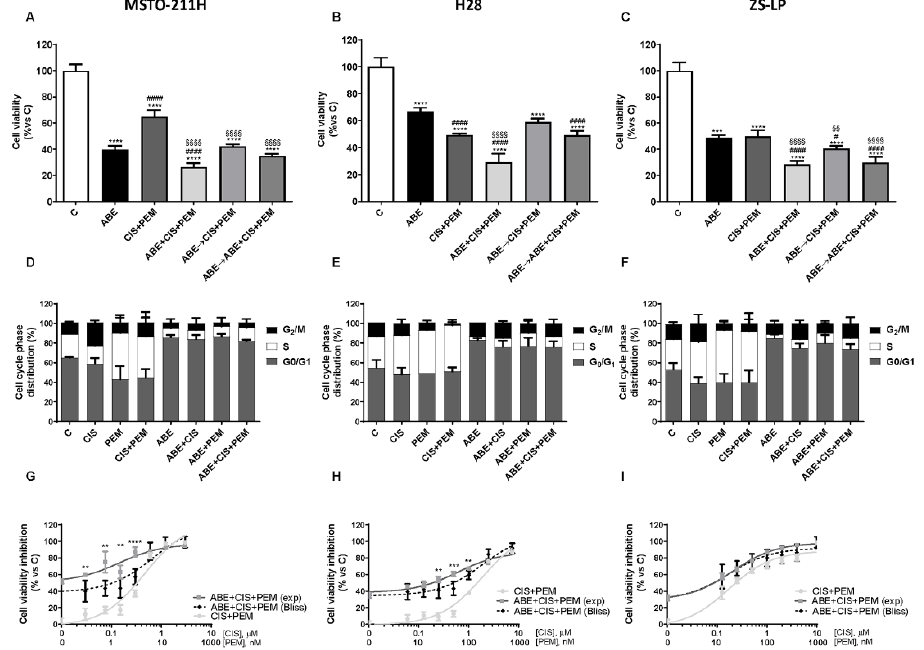
Figure 1. Effects of abemaciclib combined with cisplatin and pemetrexed on cell growth in MPM cell lines. ( A ) MSTO-211H cells were treated with abemaciclib alone (ABE, 0.5 µ M), with the combination of cisplatin (0.3 µ M) and pemetrexed (0.02 µ M) (CIS + PEM), or with abemaciclib and chemotherapy following different schedules of treatment: simultaneous drug treatment for 72 h (ABE + CIS + PEM), sequential treatment with abemaciclib for 24 h followed by chemotherapy for 48 h (ABE → CIS + PEM), and sequential combined treatment (abemaciclib for 24 h followed by the combined treatment for 48 h, ABE → ABE + CIS + PEM). ( B ) H28 and ( C ) ZS-LP cells were exposed to the above-described treatments, using abemaciclib 1 µ M, cisplatin 1 µ M, and pemetrexed 0.05 µ M. Cell viability was assessed by MTT assay and data, expressed as a percentage of cell proliferation versus control, were representative of three independent experiments. Comparison among groups was made by using analysis of variance (one-way ANOVA), followed by Bonferroni’s post-test. **** p < 0.0001 vs. control cells; §§ p < 0.01, §§§§ p < 0.0001 vs. cisplatin + pemetrexed-treated cells; # p < 0.05, ####p<0.0001 vs. abemaciclib-treated cells. For the evaluation of the cell distribution in the cell cycle phases, (D) MSTO-211H, (E) H28, and (F) ZS-LP cells were treated with abemaciclib, cisplatin, and pemetrexed alone or simultaneously combined. After 24 h MPM cell lines were stained with PI and cell distribution in the cell-cycle phases was evaluated by flow cytometry. Data are expressed as a percentage of distribution in each cell-cycle phase and are the media of three separate experiments. The type of interaction (synergistic, additive, antagonistic) was evaluated through Bliss analysis, as described in Materials and Methods section. (G) MSTO-211H, (H) H28, and (I) ZS-LP cells were simultaneously treated with abemaciclib and with increasing concentrations of cisplatin and pemetrexed for 72 h. Then, cell viability was assessed by MTT assay. Data are expressed as percent- age of inhibition versus control and are representative of three independent experiments. Student’s t -test **p<0.01, ***p<0.001, ****p<0.0001. To obtain insight into the molecular mechanisms underlying the inhibition of cell proliferation promoted by the simultaneous treatment with chemotherapy and abema- ciclib, we evaluated the expression level and the activation status of proteins involved in the regulation of the cell cycle and in signal transduction. As shown in Figure 2, the treatment with abemaciclib, alone or combined with chem- otherapy, reduced CDK6 phosphorylation at Y24 in all cell lines analyzed. Considering that Y24-phosphorylation is inhibitory, this is a peculiar result, emerged also in other cell models [22,23]. Nevertheless, abemaciclib treatment resulted in the inhibition of CDK4/6- cyclin D complex activity.